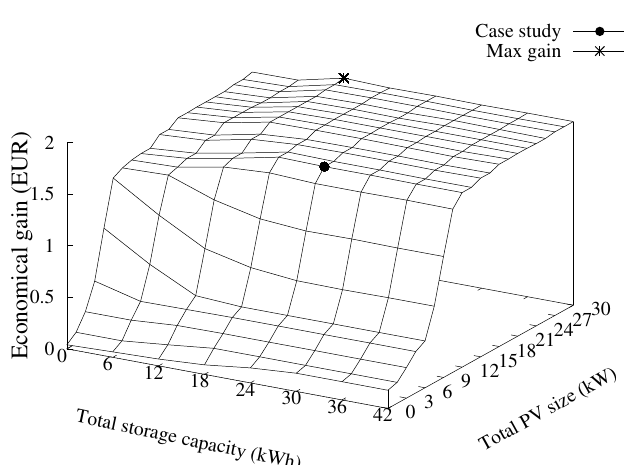
Figure 8. Economical gain of the Unified model when varying the total storage capacity and the total PV